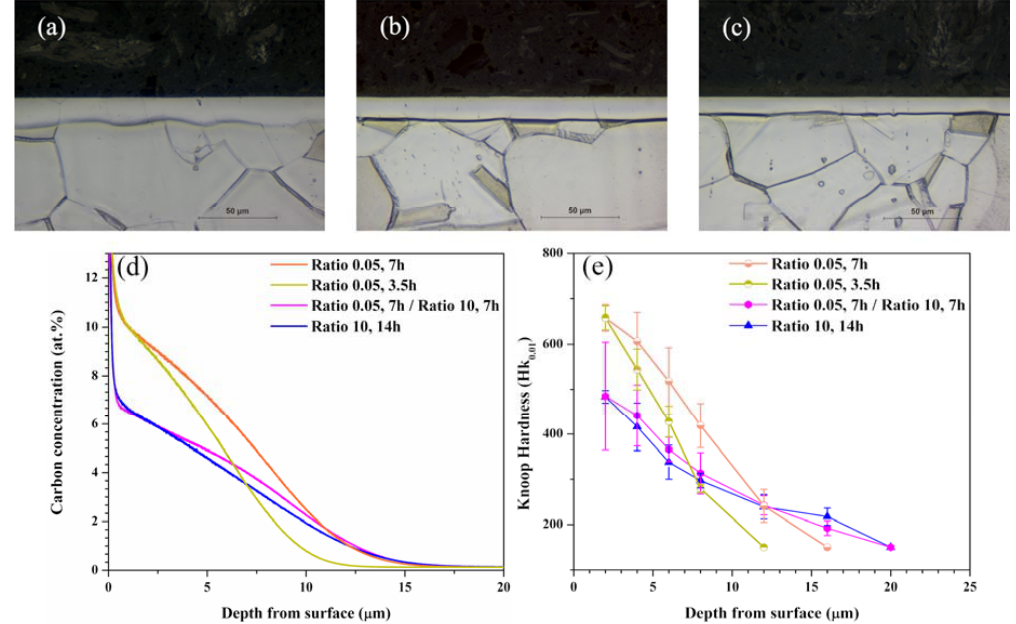
Figure 5. Cross-sectional optical microscope image of ASS samples carburized using gas mixture ratio of ( a ) 0.05 for 7 h followed by 10 for 10 h, ( b ) 0.05 for 7 h and ( c ) 0.05 for 3.5 h, ( d ) GDOES carbon concentration depth profile of ASS samples carburized by gas mixture ratio 0.05 for 7 h, ratio 0.05 for 7 h followed by ratio of 10 for 10 h and ratio of 14 for 10 h and, ( e ) hardness depth profile of ASS sample carburized by gas mixture ratio of 0.05 for 7 h, ratio of 0.05 for 3.5 h, ratio of 0.05 for 7 h followed by ratio of 10 for 7 h and ratio of 10 for 14 h.